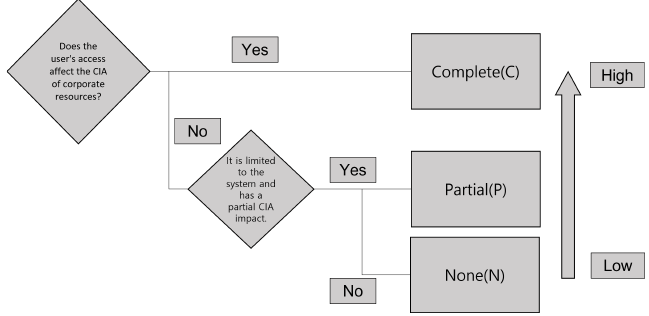
Figure 6. Accessible resource